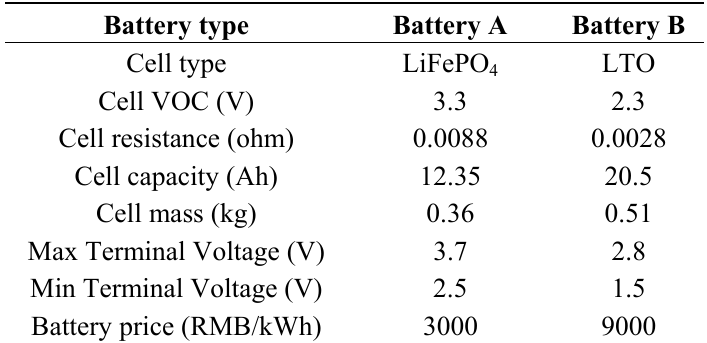
Table 6. Battery characteristics